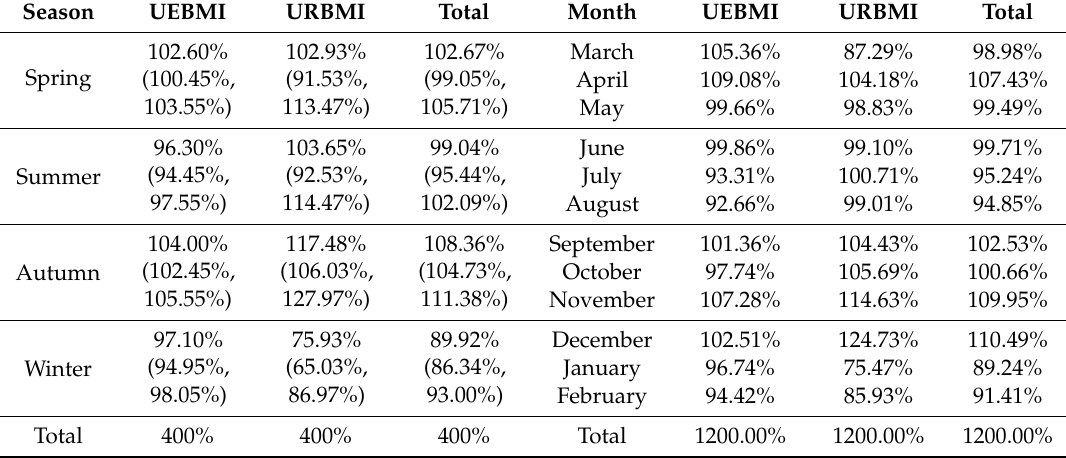
Table 2. Seasonal indexes of outpatient visits in diabetics with Urban Employee Basic Medical